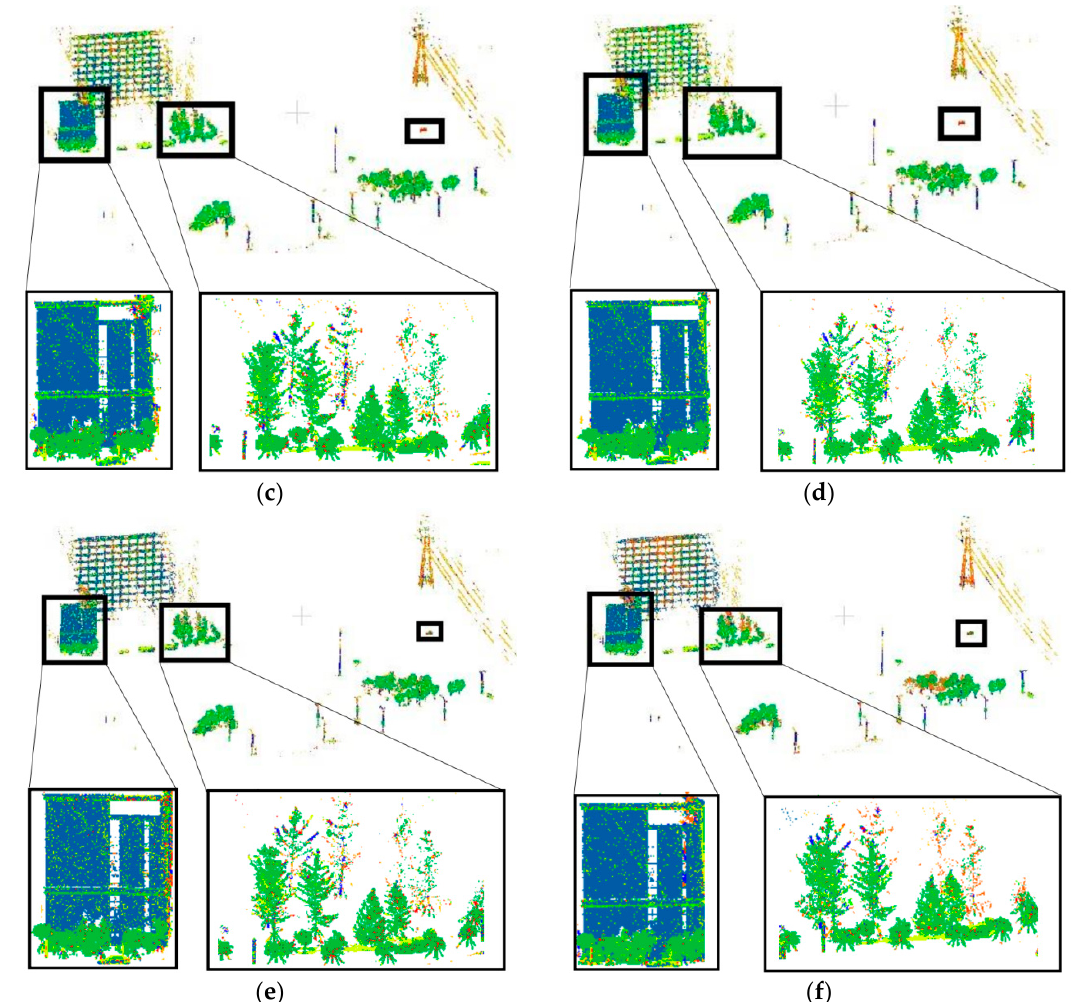
Figure 5. Classification results of Scene4. ( a ) Ground truth; ( b ) our method; ( c ) LCKSVD1; ( d ) LCKSVD2; ( e ) DKSVD; ( f ) RICA-SVM.